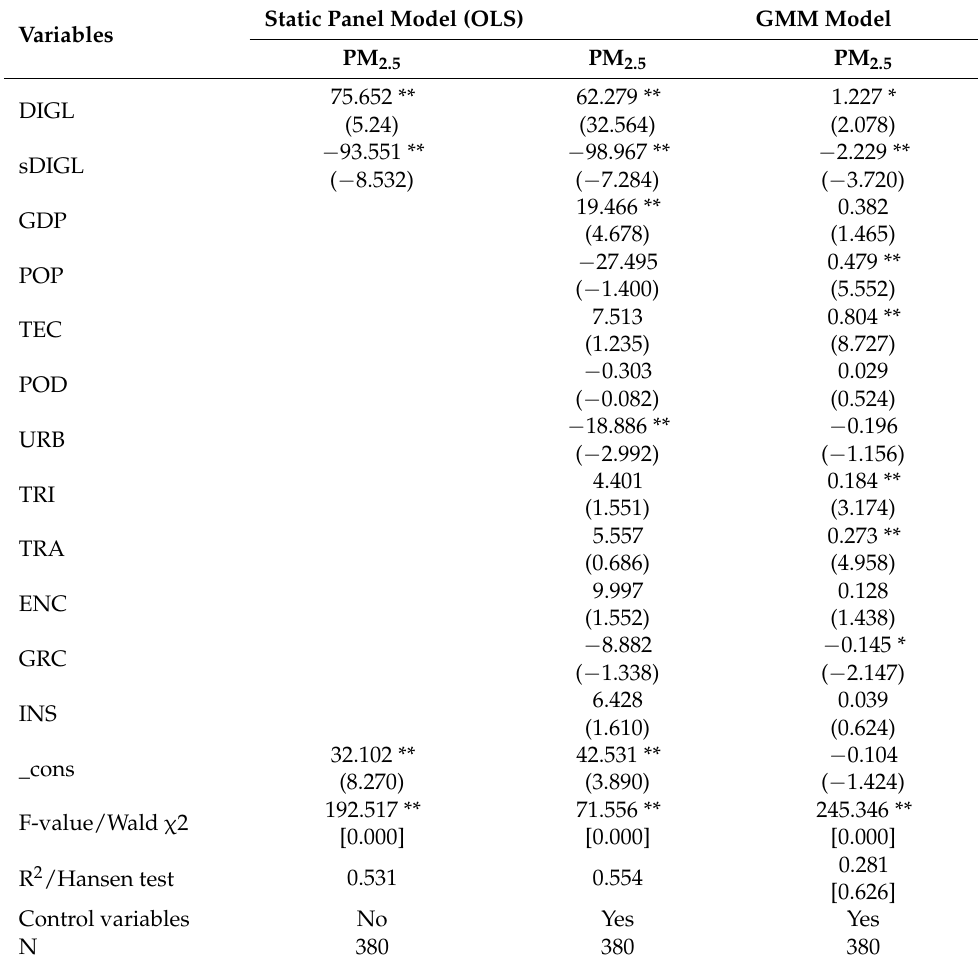
Table 4. Robustness analysis results after removing the extreme